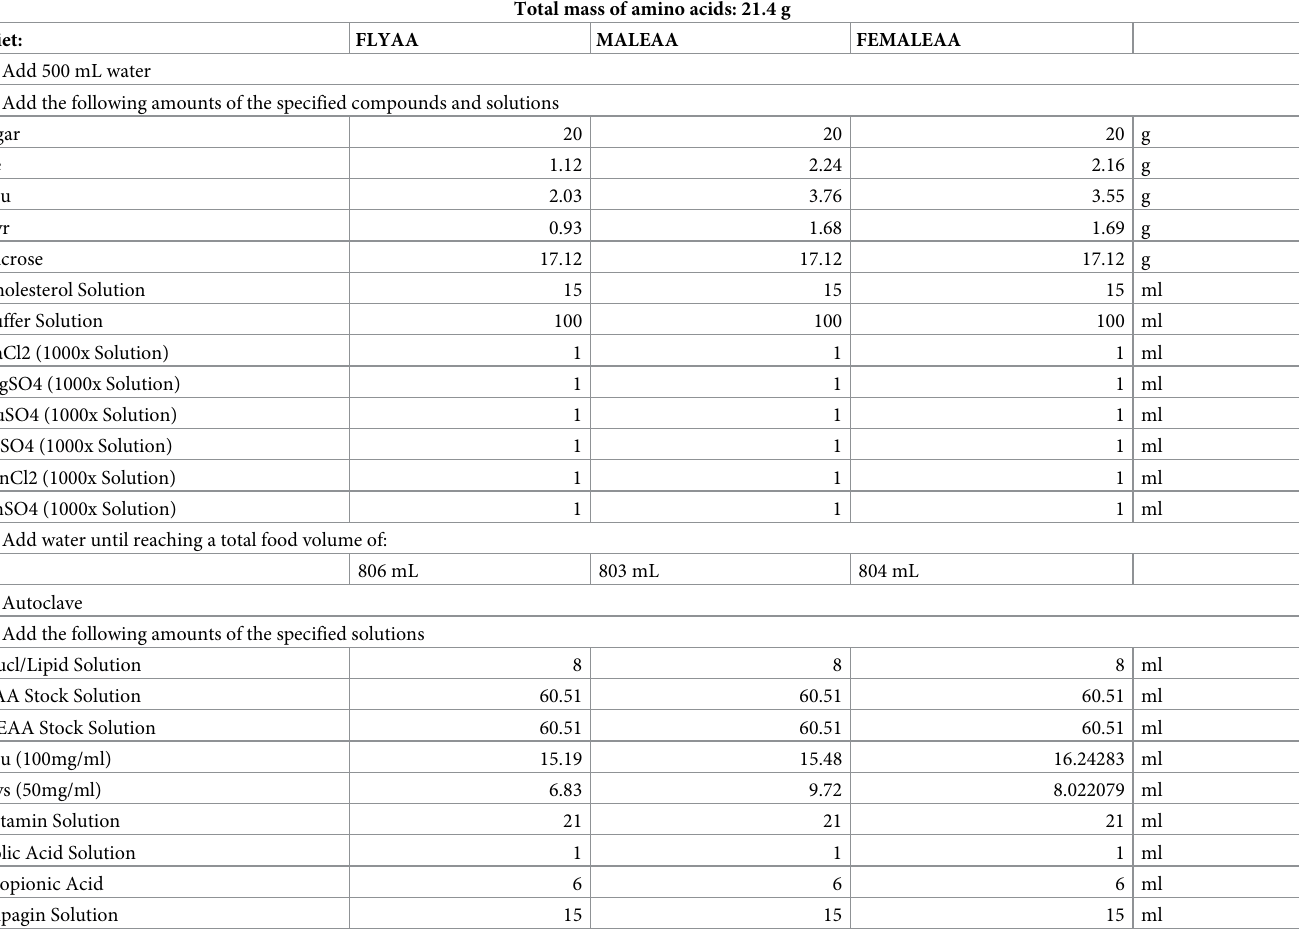
Table 2. Cooking instructions for 1000mL of Holidic